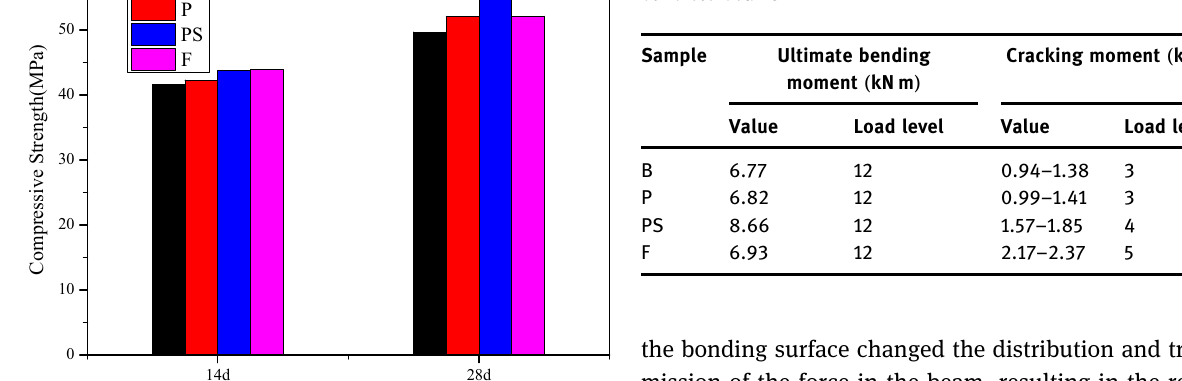
Table 6: Cracking load and ultimate bearing capacity of reinforced concrete